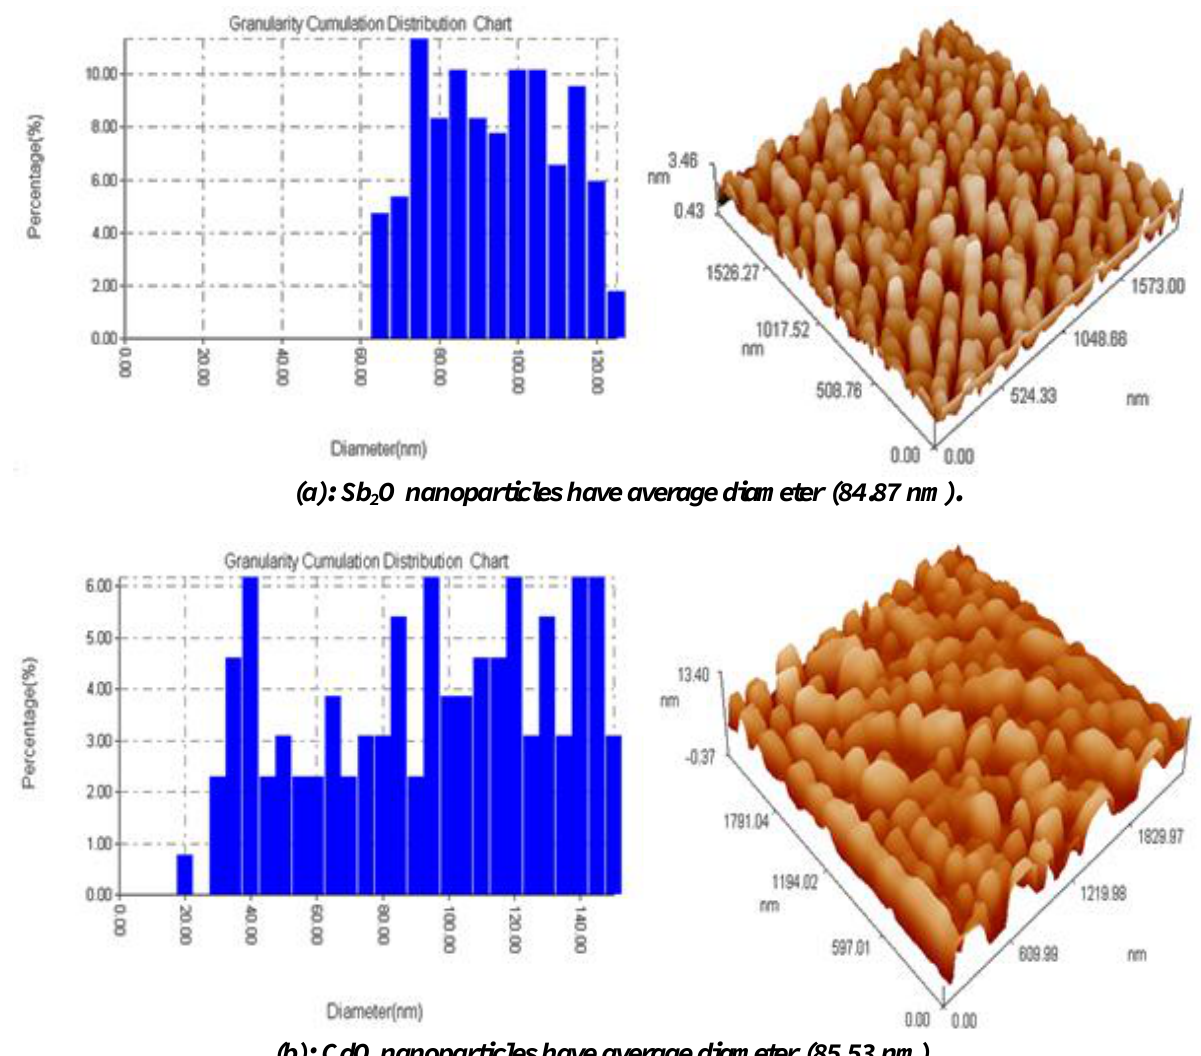
Fig. 1: Atomic force microscope (AFM) to determine the average diameter of nanoparticle and nanoparticles distribution. where (a): is Sb